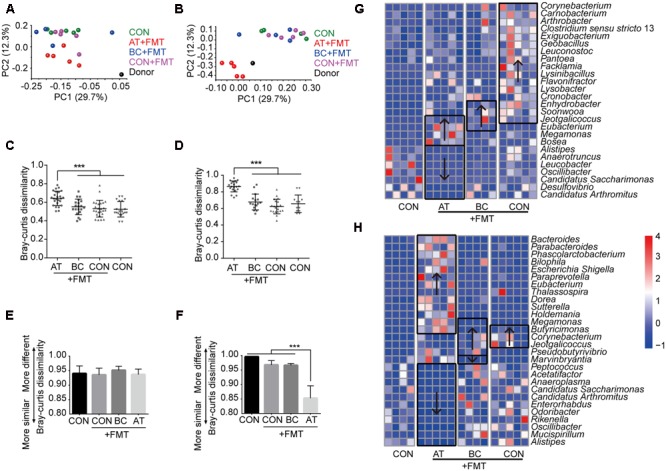
Influence of pretreatment on FMT efficiency. (A,B) Principal coordinate analyses of mucosa microbiota plotted on the first two principal components in the jejunum (A) and colon (B). (C,D) Bray–Curtis dissimilarities using OTU taxa of the jejunum (C) and colon (D) mucosa bacterial communities after FMT compared with control mice. (E,F) Bray–Curtis dissimilarities of the mouse jejunum (E) and colon (F) mucosa bacterial communities after FMT compared with the donor bacterial community. (G,H) The altered taxa in abundance at the genus level in the jejunum (G) and colon (H). The significantly altered taxa compared with control mice are enclosed in boxes, and arrows indicate increased (↑) or decreased (↓) abundance. Only taxa with p < 0.05 are included. Data are presented as means ± SD. ∗∗∗p < 0.001. For all figures: FMT, fecal microbiota transplant group; CON, control group; BC, bowel cleansing group; AT, antibiotics group.